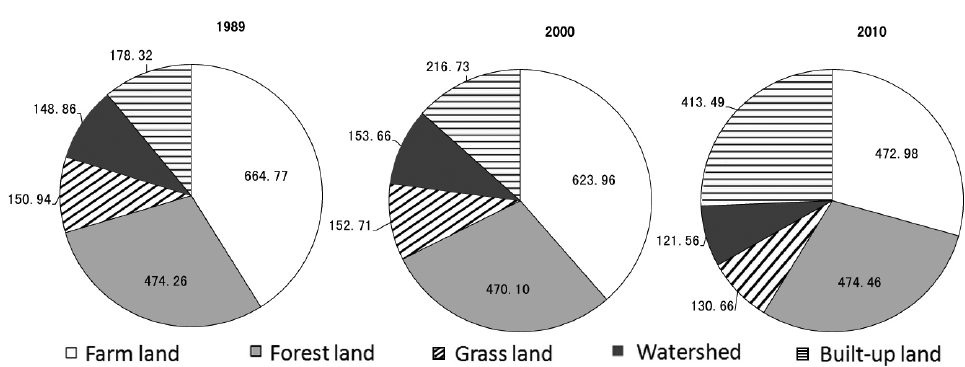
Figure 6. Population density, road density and connectivity from 1989 to 2010 (figure drawn by the author)